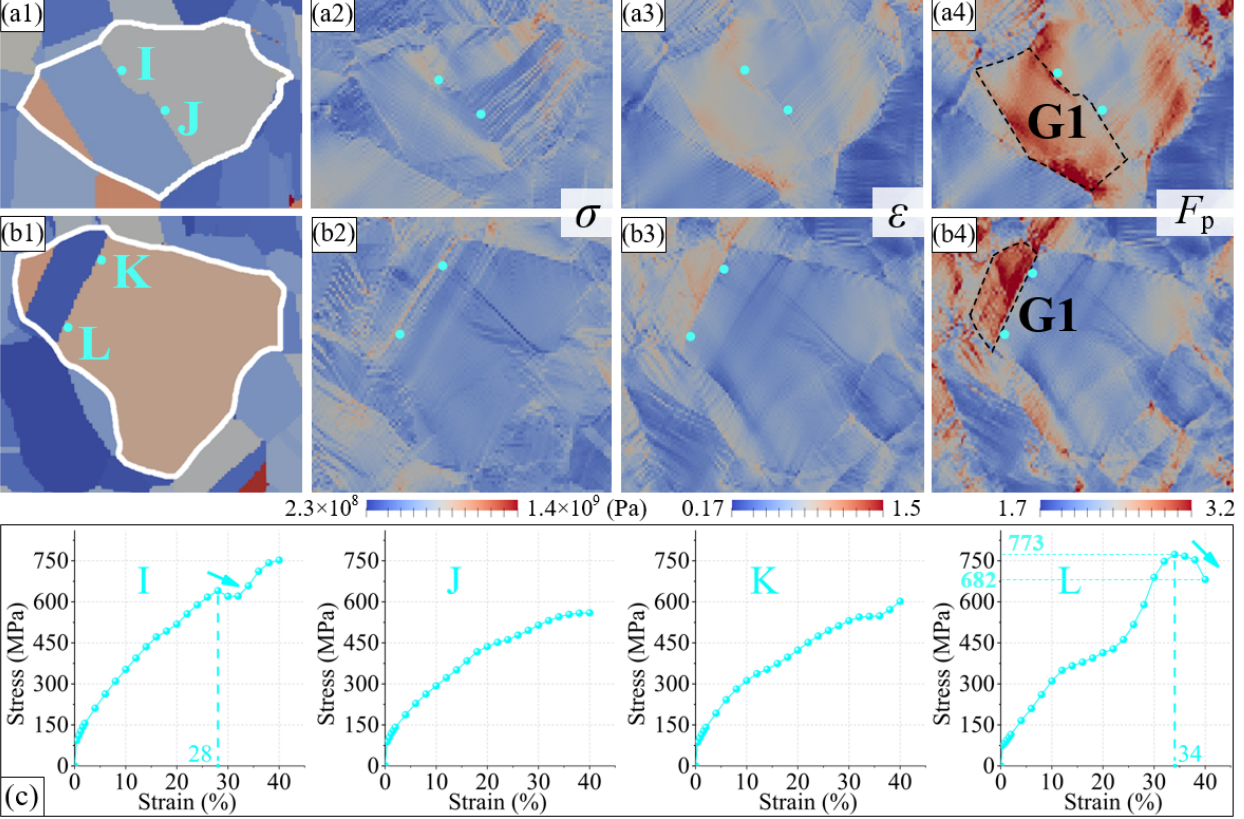
Figure 10. ( a1 ) The position of points near Σ 3 boundaries at initial simulation state in grain group GG Ⅲ . ( a2 – a4 ) The distribution of stress, strain, and plastic deformation gradient at final simulation state in grain group GG Ⅲ . ( b1 ) The position of points near Σ 3 boundaries at initial simulation state in grain group GG Ⅳ . ( b2 – b4 ) The distribution of stress, strain, and plastic deformation gradient at final simulation state in grain group GG Ⅳ . ( c ) The stress variation of points I–L.